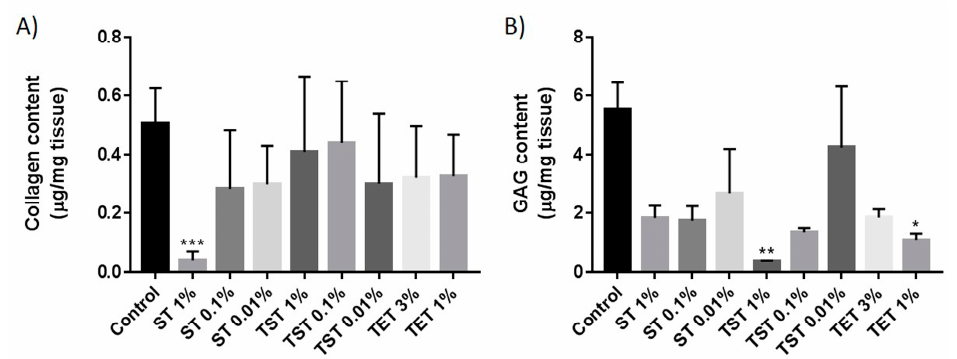
Figure 5. Collagen and GAG quantification in native tissue and DTs. ( A ) Collagen in native tissue and DTs was quantified using the Sircol assay; ( B ) Quantification of GAGs in native tissue and DTs using the Blyscan assay. Results are presented as means ± SD. *** p < 0.001, ** p < 0.01, * p < 0.05.